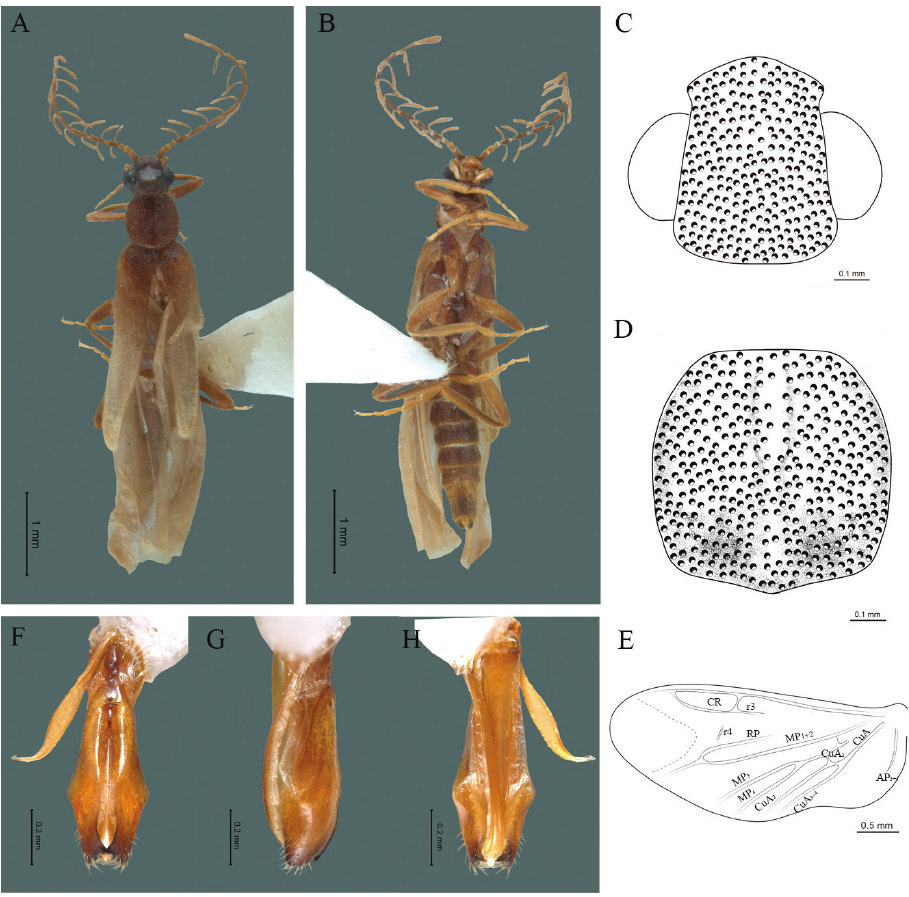
Figure 10. Cenophengus hnogamui Vega-Badillo et al. 2021, male. Habitus: A dorsal B ventral C head dorsal D pronotum dorsal E hind wing. Wing venation: CR = Radial Cell; r3 = radial 3 vein; r4 = radial 4 vein; RP = Posterior Radial vein; MP1+2 = Posterior Median vein; CuA = Cubital vein; AA and AP = Anterior and Posterior Anal veins. Aedeagus: F dorsal view G lateral view H ventral